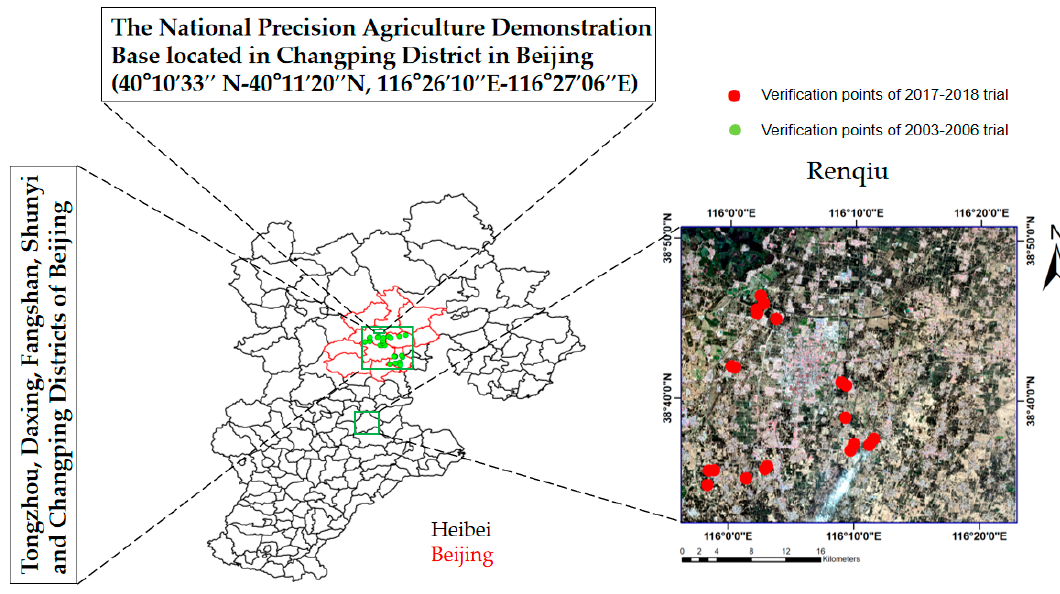
Figure 1. Location of the study area. Table 1. Summary of experiment designs and ground-sampling data used in this